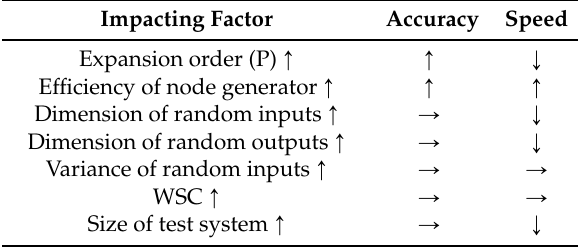
Table 8. Summary on the factors influencing the performance of the proposed SG-PLF